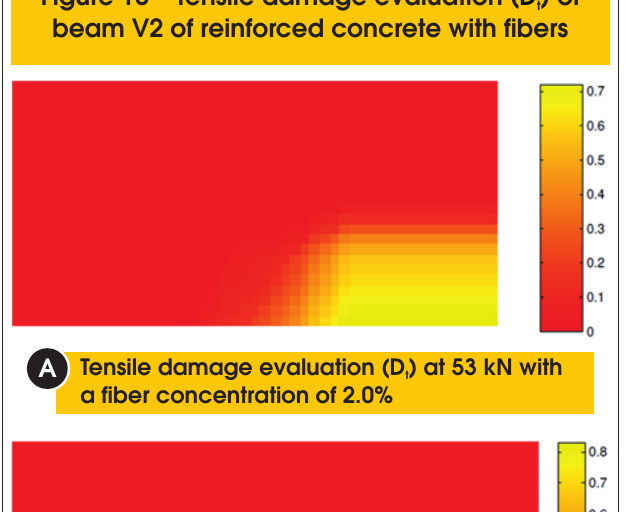
Figure 13 – Tensile damage evaluation ( ) of beam V2 of reinforced concrete with fibers